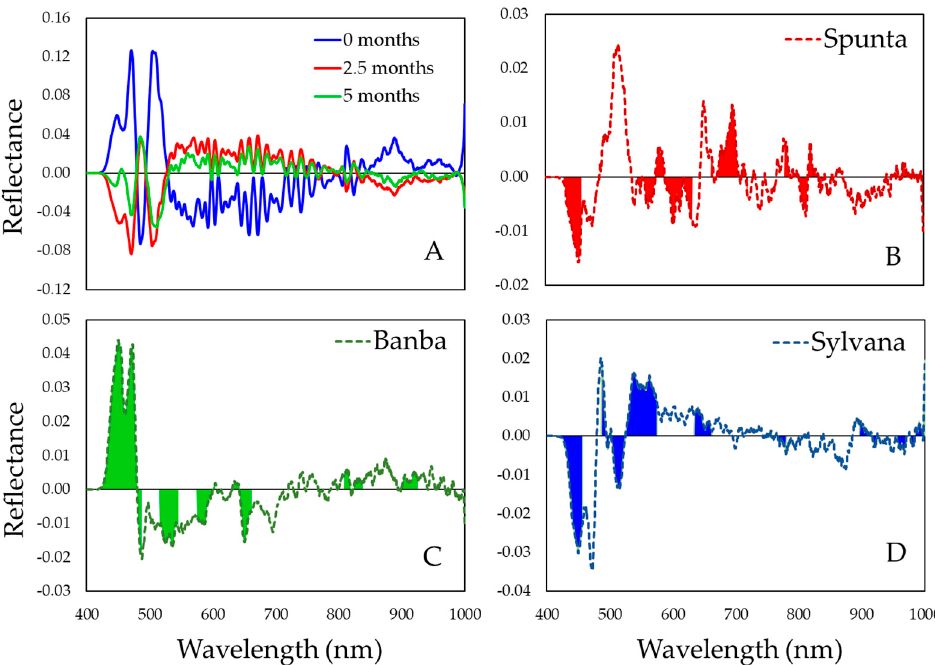
Figure 5. Spectra reflectance data upon pre-processing (normalization, Savitzky–Golay first derivative and mean centering) that were internally captured in the flesh of the tuber during storage for 0, 2.5, or 5 months at 5 ◦ C ( A ) from 3 commercial potato cultivars (Spunta, Banba, and Sylvana), along with the most important regions within each cultivar for the freshness assessment ( B – D